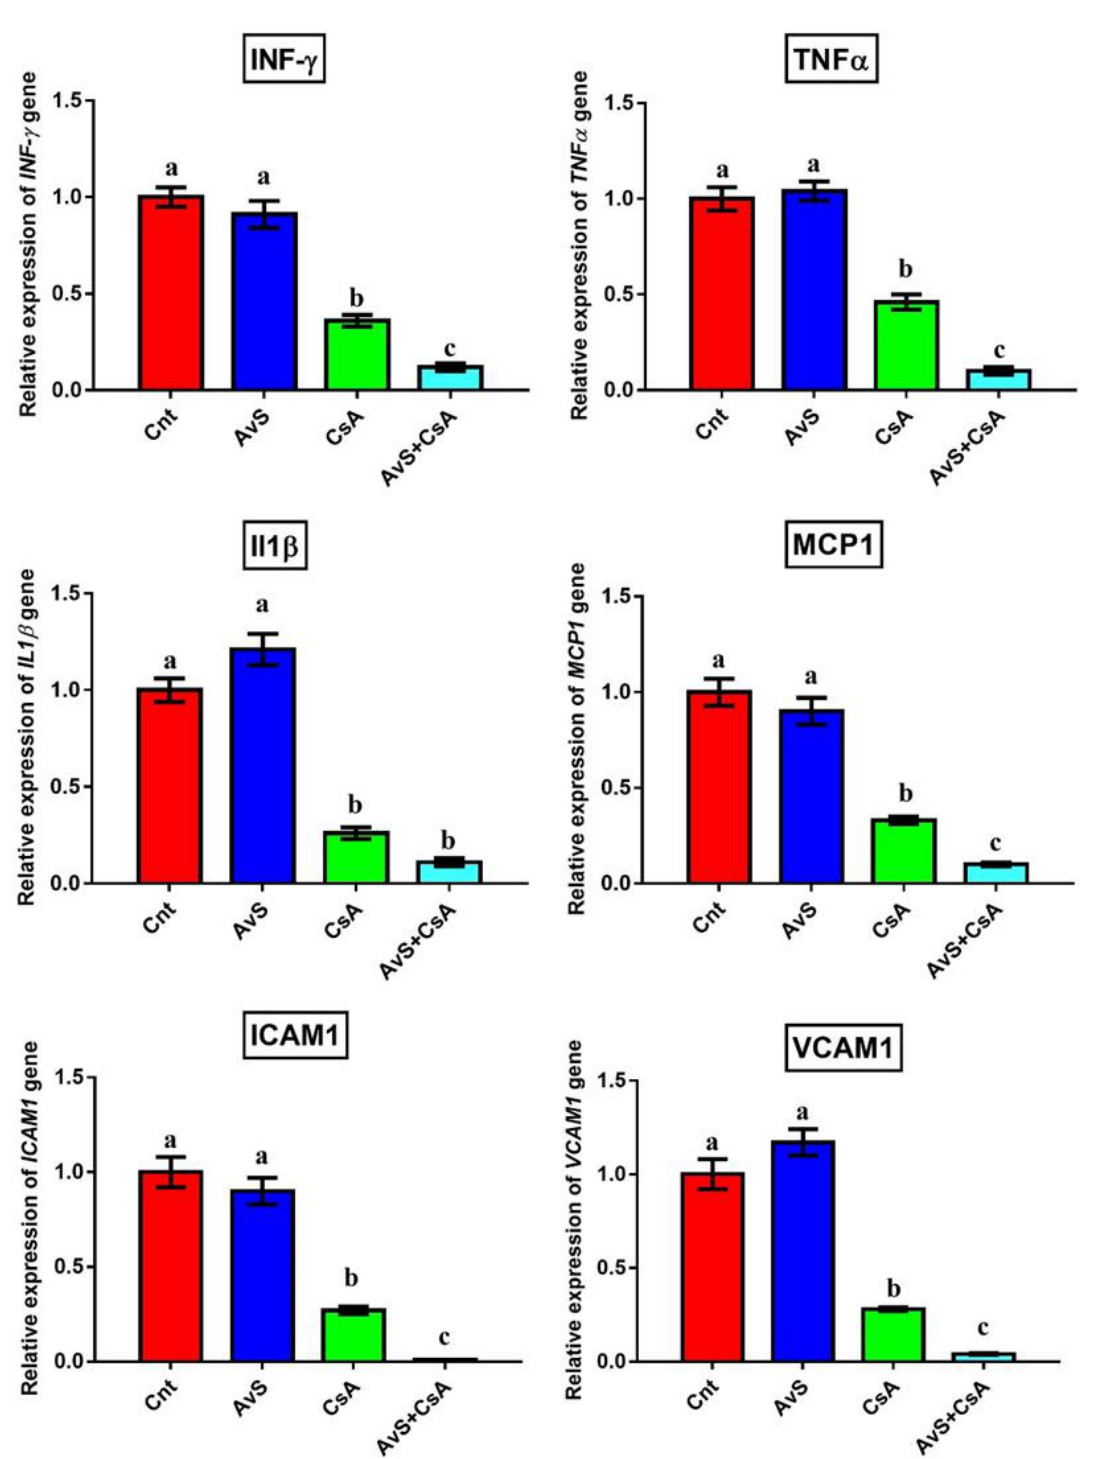
Figure 3. The effects of AvS and/or CsA treatment on the levels of IFN- γ , TNF α , IL1 β , MCP1 , ICAM1 , and VCAM1 in rat kidneys, as detected by qRT-PCR. Data are presented as fold change (mean) ± SEM ( n = 7/group). Columns with different letters (a – c) are significantly different at p < 0.05.